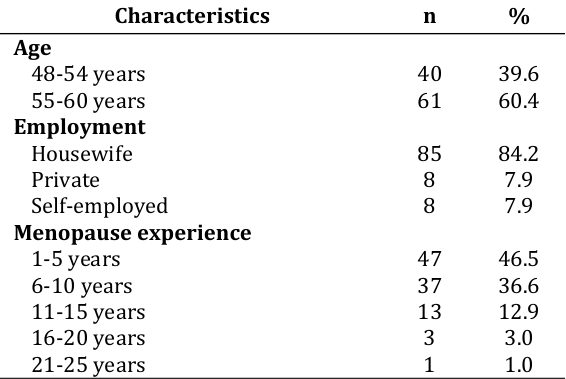
Table 1. Characteristics of Respondents (n=101)